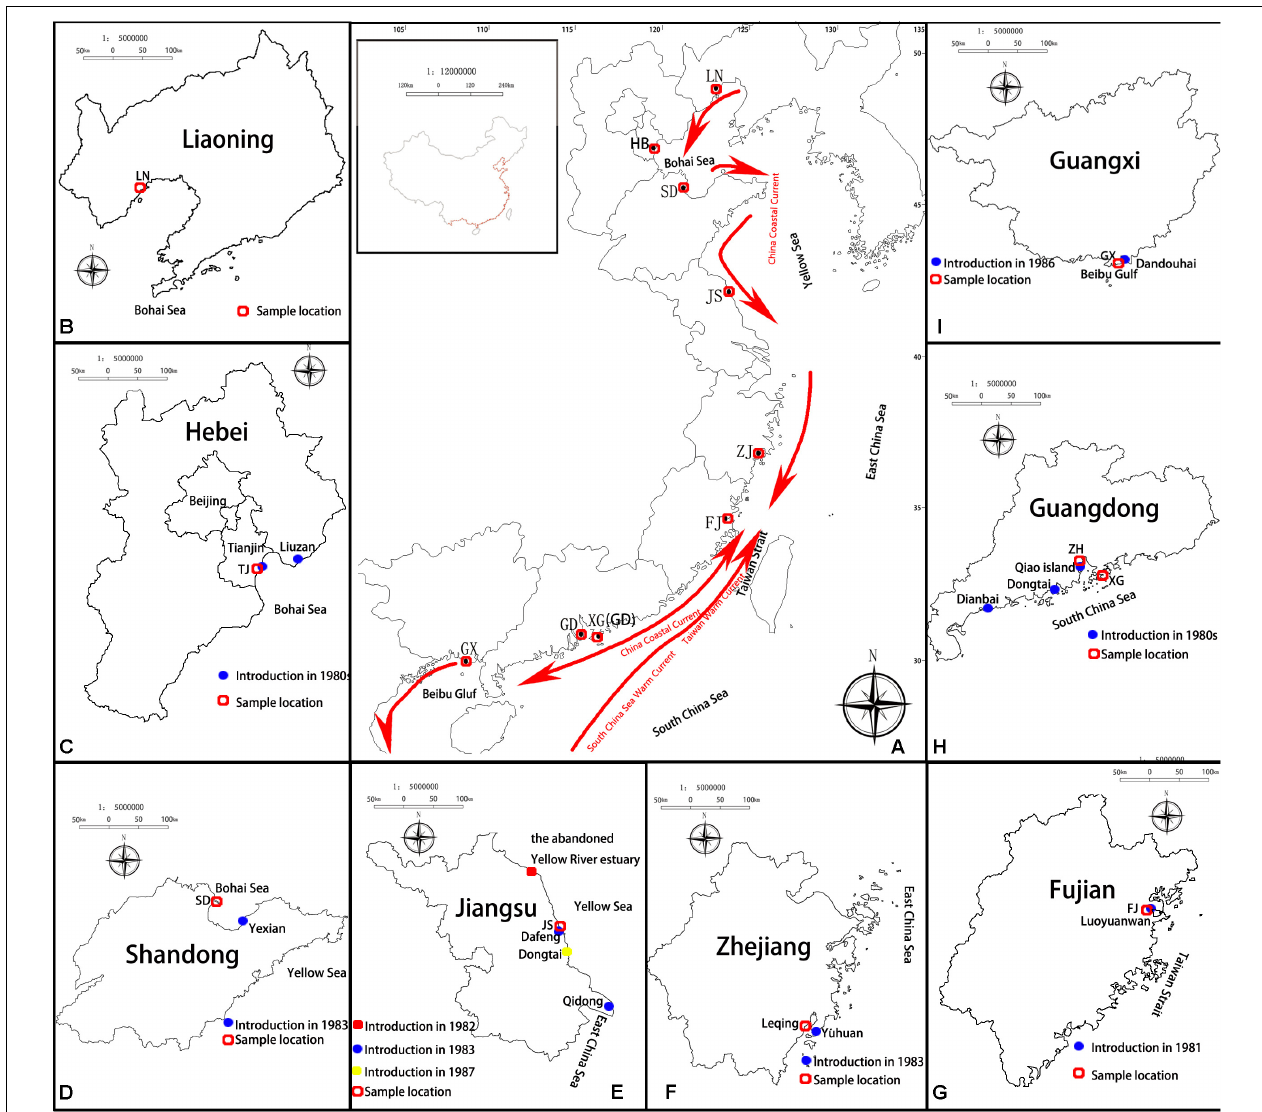
FIGURE 1 | Introduction and sampling sites of Spartina alterniflora on the coast of China. (A) General view; the red arrow shows the direction of the China coastal current, and the introduction sites of (B) Liaoning Province; (C) Hebei Province (Tianjin); (D) Shandong Province; (E) Jiangsu Province; (F) Zhejiang Province; (G) Fujian Province; (H) Guangdong Province; and (I) Guangxi Province.